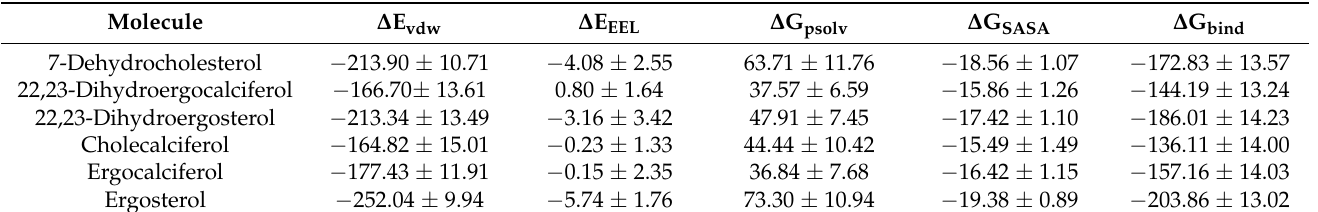
Table 6. MM/PBSA binding free energy (in kJ/mol) for vitamin D isoforms binding to SARS-CoV-2 main protease.